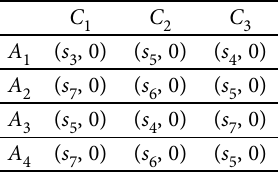
Table 4. 2-tuple linguistic decision matrix 1 R 